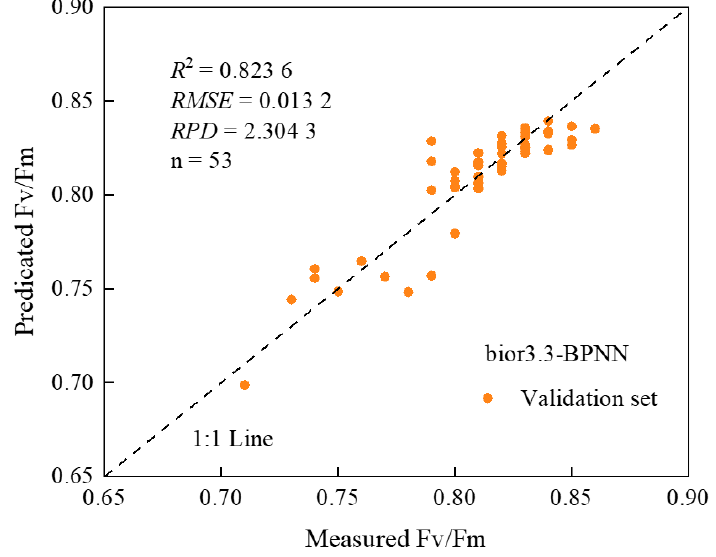
Figure 8. 1:1 relationship between predicted and measured values of Fv/Fm.